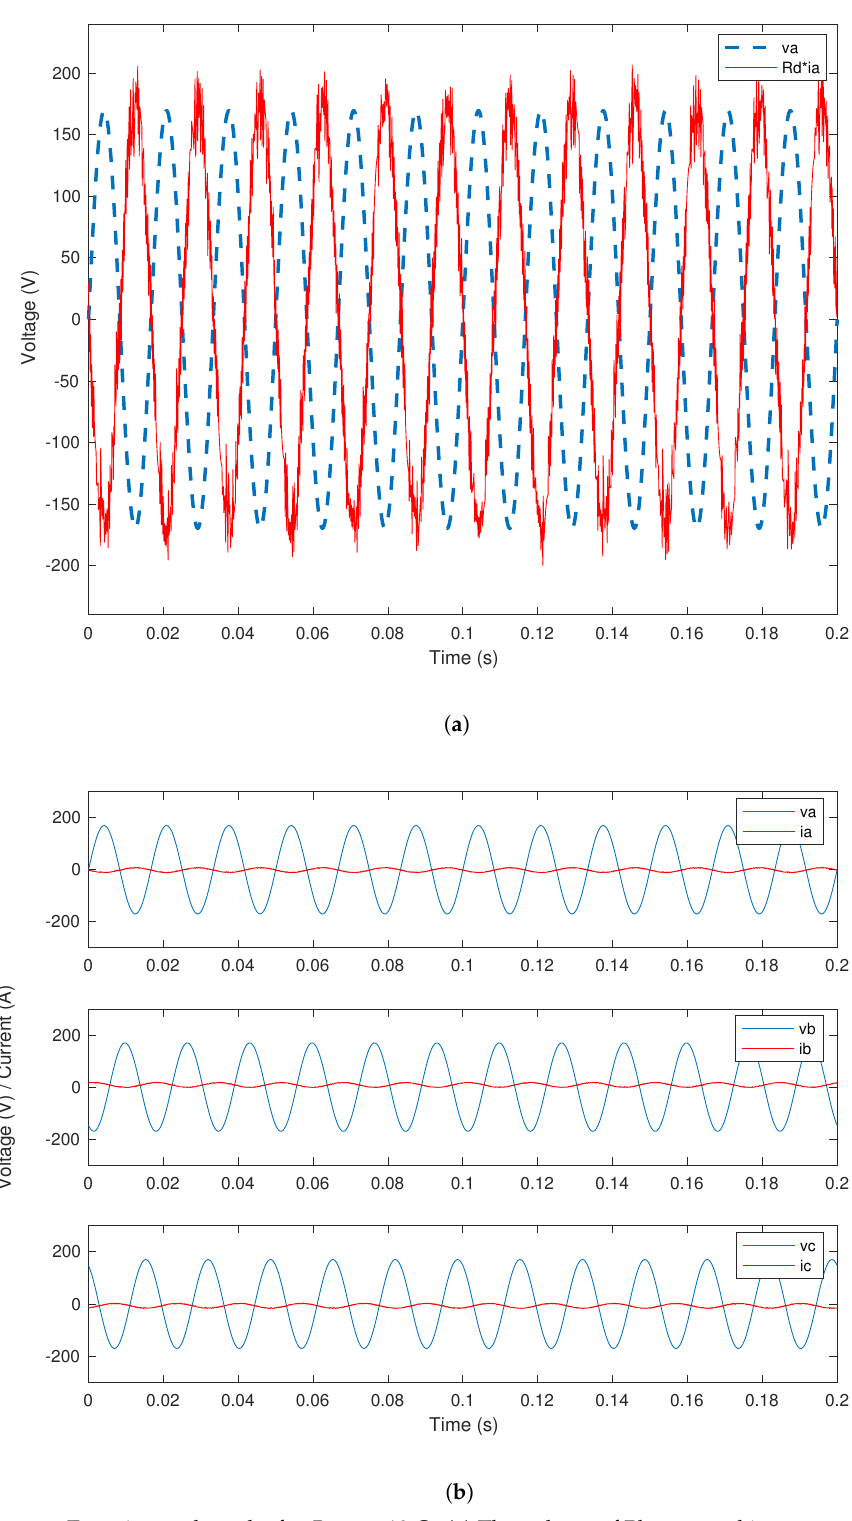
Figure 10. Experimental results for R d = − 10 Ω . ( a ) The voltage of Phase-a and its current multiplied by R d . ( b ) The input voltage and current of each